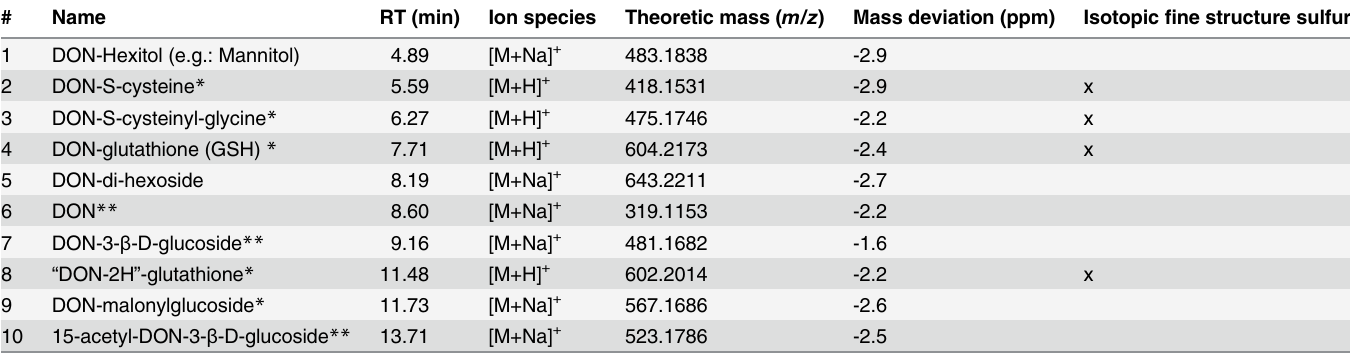
Table 1. Overview of nine different DON biotransformation products in DON treated wheat samples. Initial annotation for all biotransformation products was performed based on the maximum mass deviation of ± 3 ppm and relative retention order (deviation retention time: ± 0.2 min) compared to the same biotransformation products annotated in the former study [24].